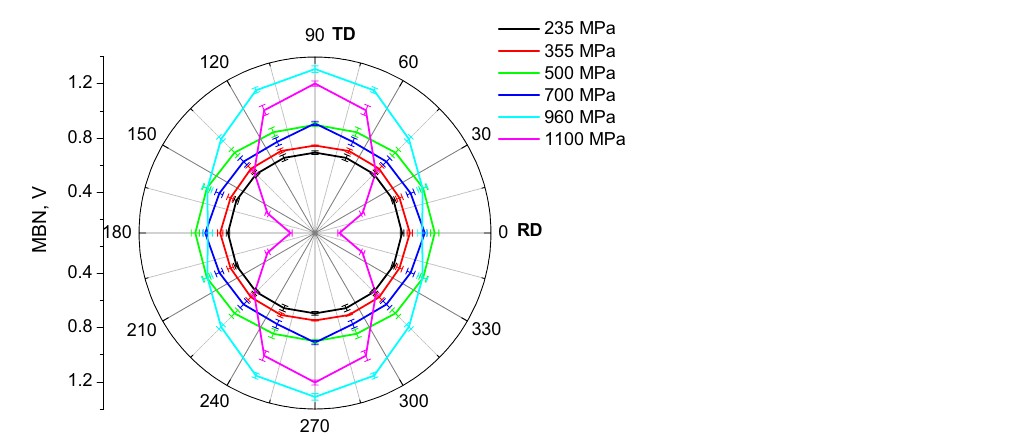
Figure 10. Angular distribution of MBN as a function of nominal σ YS .